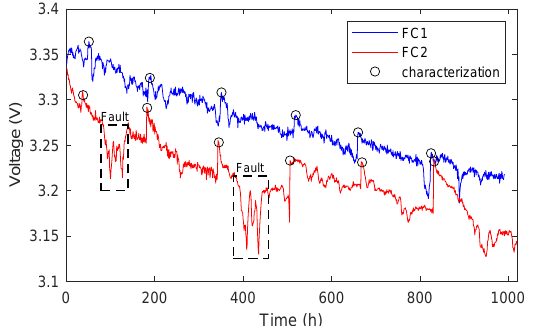
Figure 2. The voltage-degradation curves of FC1 and